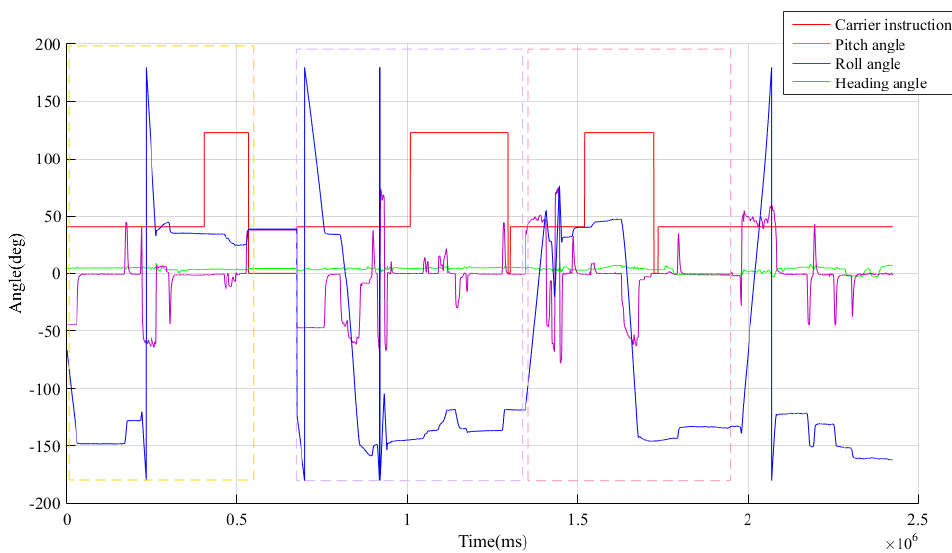
Figure 10. Angle information issued by the carrier to the pod.